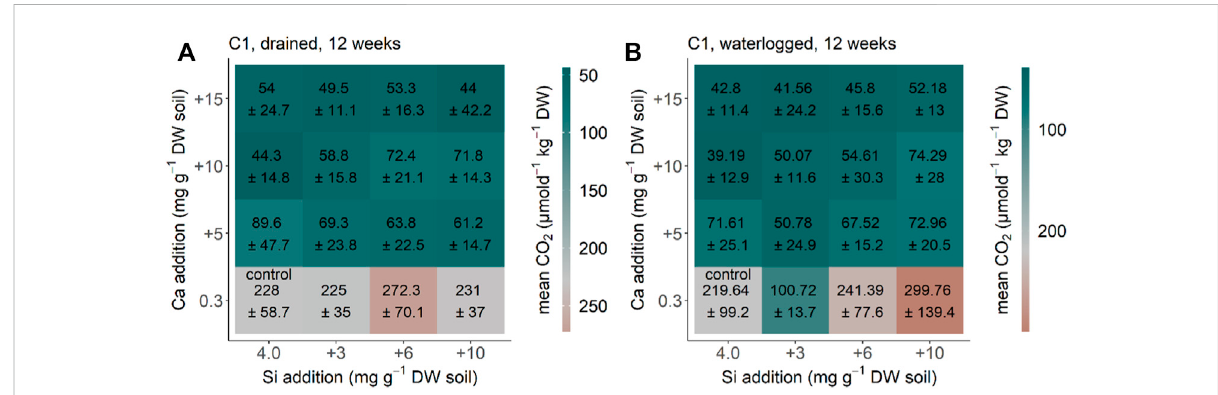
FIGURE 1 CO 2 production for the soil from Siberia Chersky C1, NE-Russia after 12 weeks (A) drained and (B) waterlogged incubation. Each square represents atreatment(n=5) withSi (+0, +3,+6,and+10 mg g − 1 DW)and Ca(+0, +5,+10,and +15 mg g − 1 DW).Color represents thedifferencesof thetreatmentofCO 2 productionincomparisontothecontroltreatment,withgreen – blueshowingadecreasedCO 2 productionandredshowingan increased CO 2 production in comparison to the control treatment.